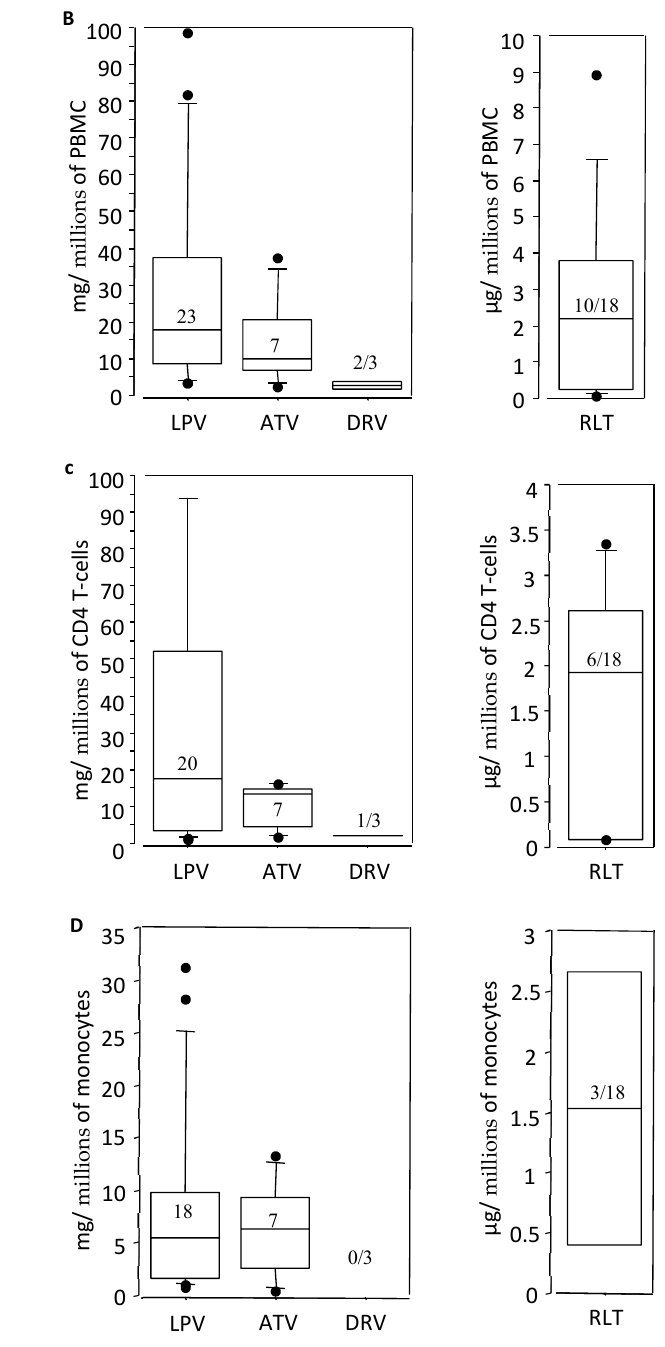
Figure 4. Intracellular drug concentrations in Plasma, PBMC, CD4 T-cells, and monocytes. The cumulative pharmacological data of the 4 drugs analyzed at all the time points. As lopinavir determinations were used to test our methodology, the number of samples is over the expected value. The cellular drug concentration was measured per million cells. The histogram represents only the detected positive values during all time points. Of note, darunavir drug concentration was detected only at ( A ) 3 time-points in plasma, ( B ) 2 time-points in PBMC, ( C ) 1 in CD4 T-cells, and ( D ) remained undetectable in monocytes. Additionally, most of the time, raltegravir drug concentration was undetectable (77%). The number in the box represents the number of positive time-points/total time-points analyzed. LPV = Lopinavir, ATV = Atazanavir, DRV = Darunavir and RLT = Raltegravir. A. Plasmatic determinations. B. PBMC determinations. C. CD4 T-cell determinations D. Monocyte